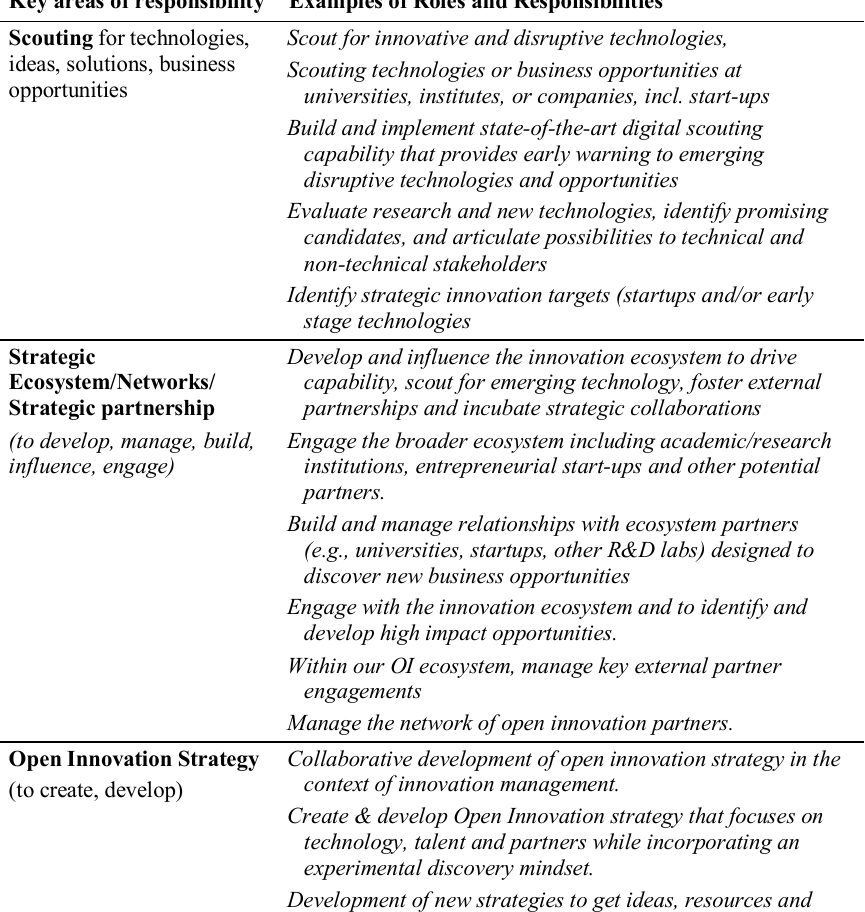
Table 2. Key areas of roles and responsibilities based on analysis of 23 job offers with Key areas of responsibility Examples of Roles and Responsibilities Scouting for